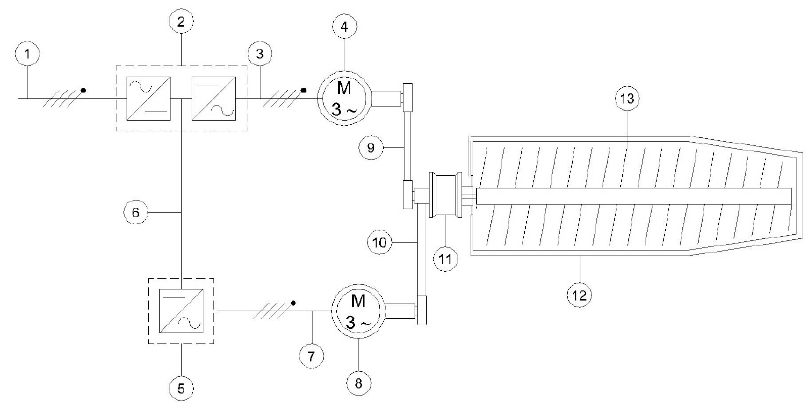
Figure 2. Decanter electro-mechanical transmission: ( 1 ) power supply; ( 2 ) screw energy recovery